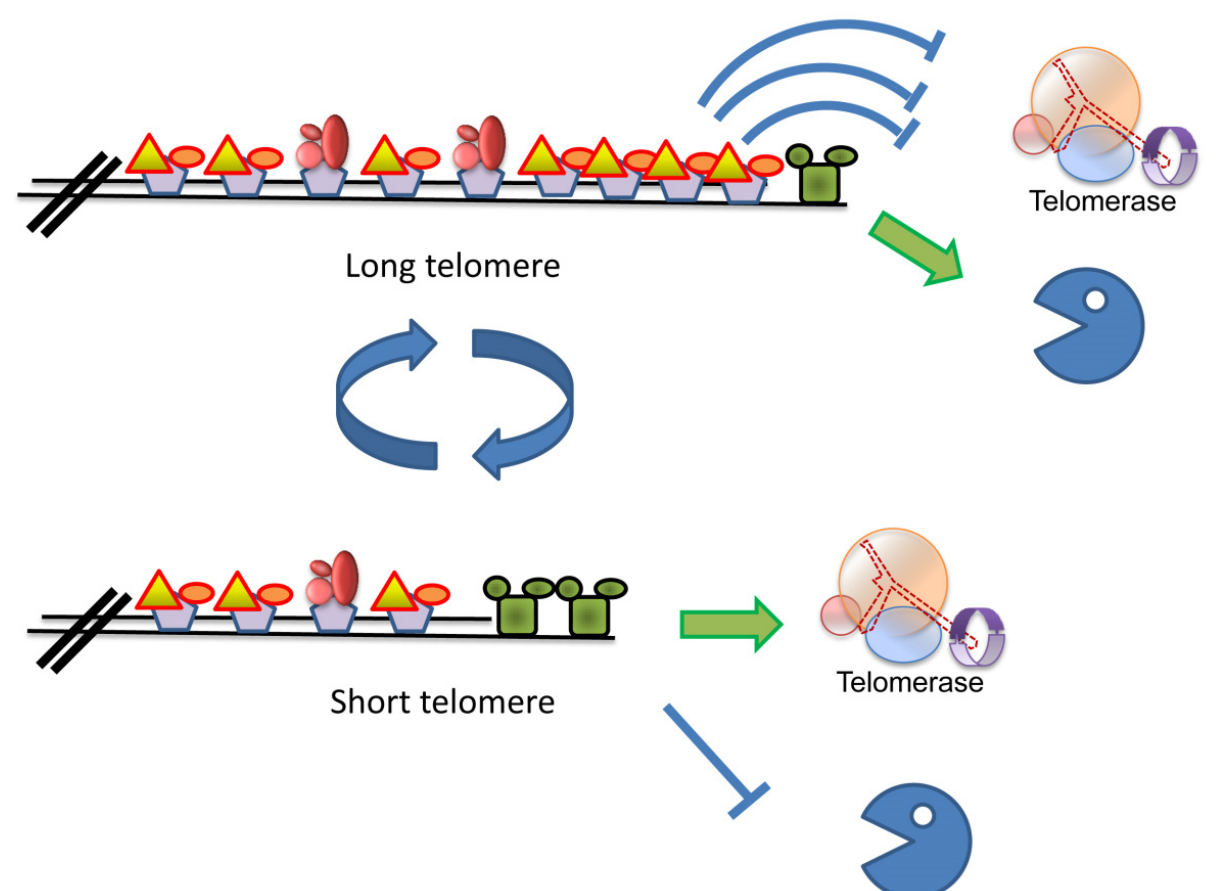
FIGURE 2: Schematic model of the mechanism(s) that keep telomere length homeostasis. Long telomeres carry many copies of the Rap1 protein, and its associated Rif1 and Rif2 proteins, which prevent recruitment of telomerase. Telomeres in this state are said to be in a “non- extendable” configuration [69]. Telomeres shorten as a consequence of the “end replication problem” or by the action of exonucleases (Pacman). It is still unclear what circumstances allow recruitment of nucleases. Short telomeres carry a low number of Rap1/Rif units, and the CST is able to recruit telomerase, thus elongating the telomere. It is assumed that the presence of an active telomerase prevents re- cruitment of shortening